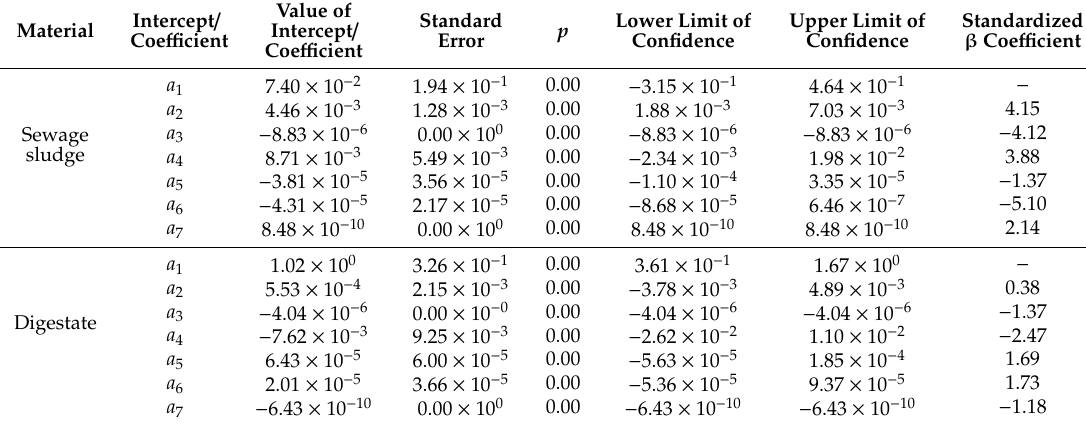
Table A6. Statistical evaluation of model coe ffi cients for the CP in CSF from sewage sludge and digestate. Material Standardized β Coe ffi